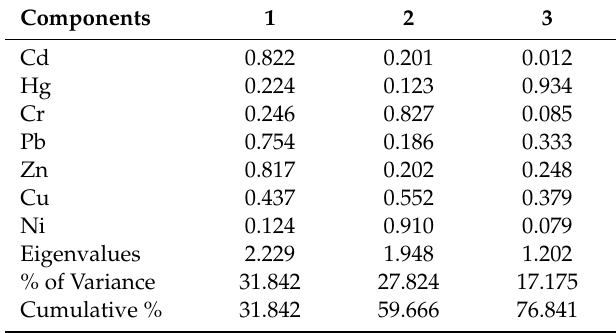
Table 3. Total variance explained and component matrix a of heavy metals in this